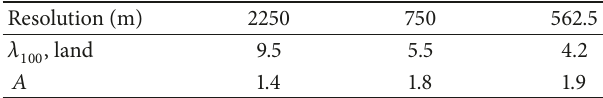
Table 6: Roll characteristics from simulations using different reso- lutions on 25 May